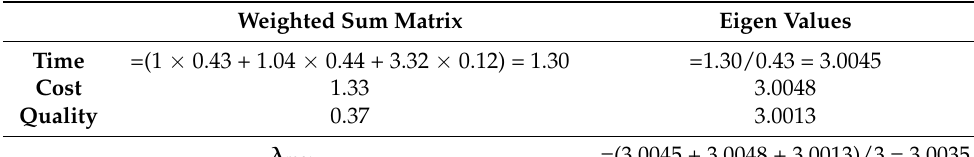
Table 9. Weighted sum matrix and Eigen values.